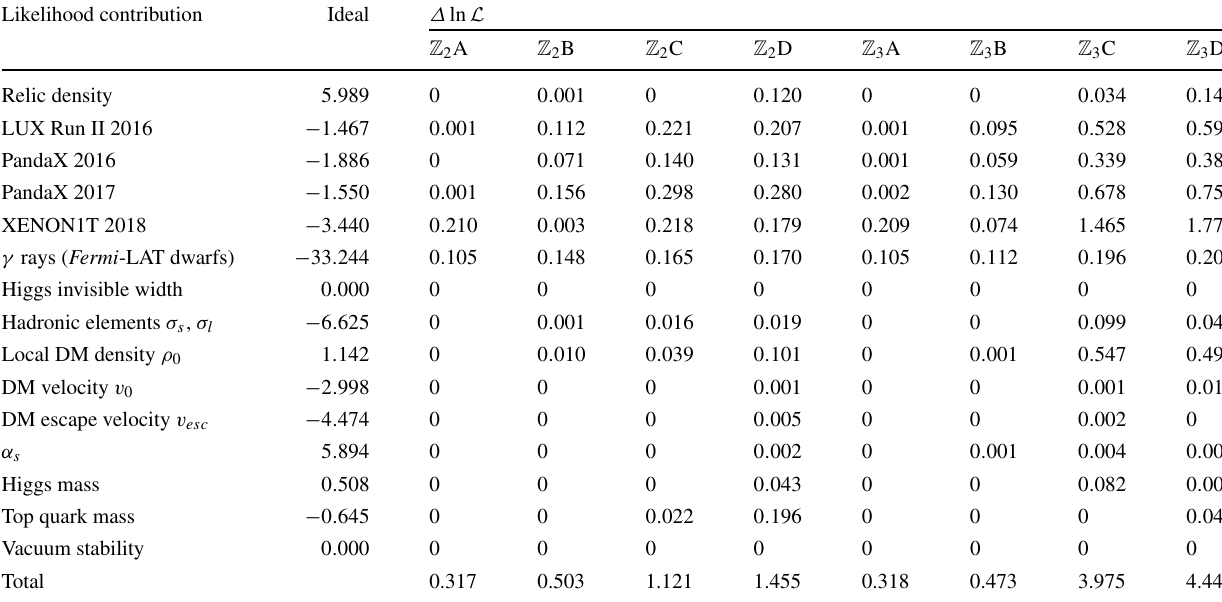
Table 6 Individual contributions to the Δ log-likelihood for the vari- ous best-fit points (see Tables 5 and 7) compared to an ‘ideal’ case. We take this to be the background-only likelihood for exclusions, and the central observed value for detections. Note that because each likelihood is dimensionful, the absolute values are less meaningful than the off- set with respect to another point (see section 8.3 of Ref. [15] for more